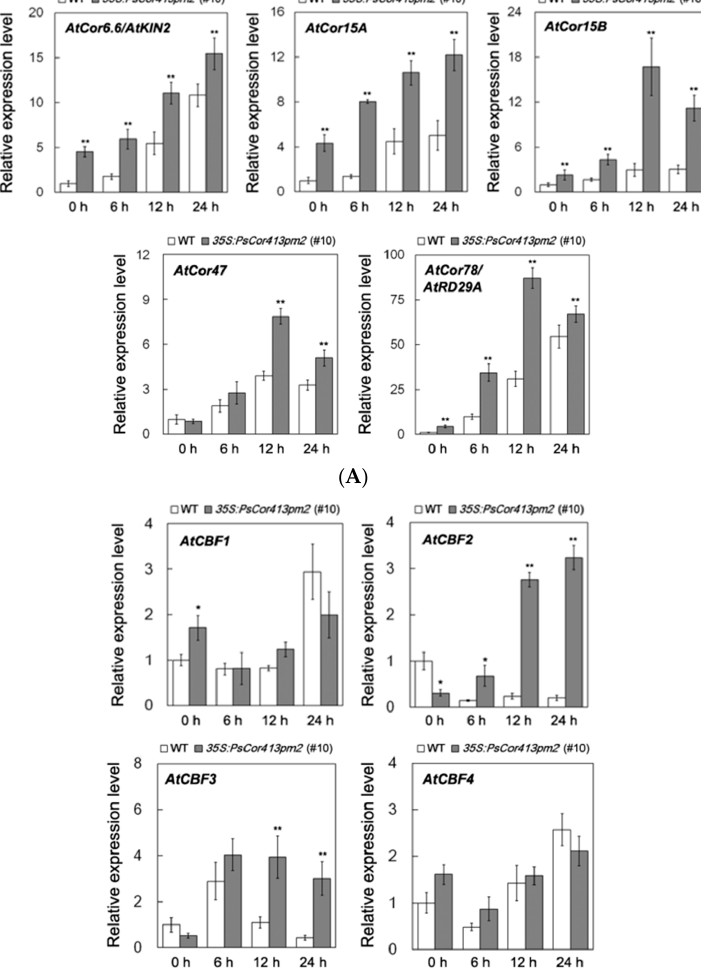
Figure 7. Expression of stress-associated genes in transgenic Arabidopsis and wild type (WT) seedlings under cold stress. Two-week-old transgenic Arabidopsis line (#10) overexpressing PsCor413pm2 and WT seedlings were treated at 4 °C for the indicated time periods. Expression of the AtCor6.6/AtKIN2 , AtCor15A , AtCor15B , AtCor47 , AtCor78/AtRD29 ( A ) and AtCBF1 to AtCBF4 ( B ) genes was investigated using qPCR. The AtActin2 gene was used as an internal control, and the transcript level in the untreated WT seedlings was set as 1.0. Asterisks indicate significant differences between WT and transgenic lines (* p < 0.05; ** p < 0.01; student’s t test). Error bars show the SD of the values from three replicates.